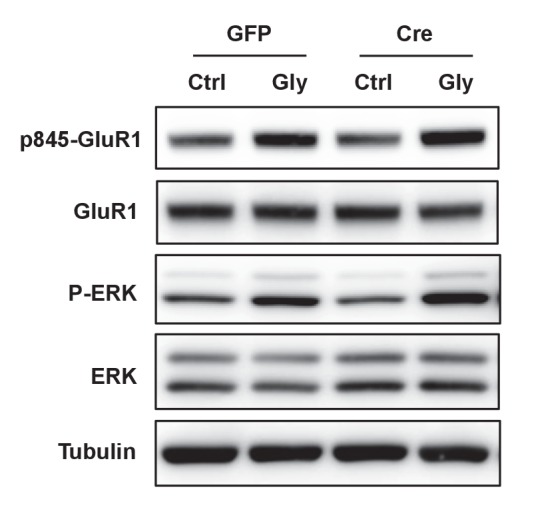
Loss of IDOL impairs LTP in neurons and hippocampal slices.(A) Immunoblot analysis of total proteins from Mylipflox/flox hippocampal neurons transduced with either AAV-CamKII-GFP or AAV-CamKII-CRE-GFP at DIV 5. At DIV21, neurons were stimulated in a cLTP protocol (see Materials and Methods). Neurons were harvested 10 min after glycine stimulation. Each lane represents pooled samples from two wells of a 12-well-plate.